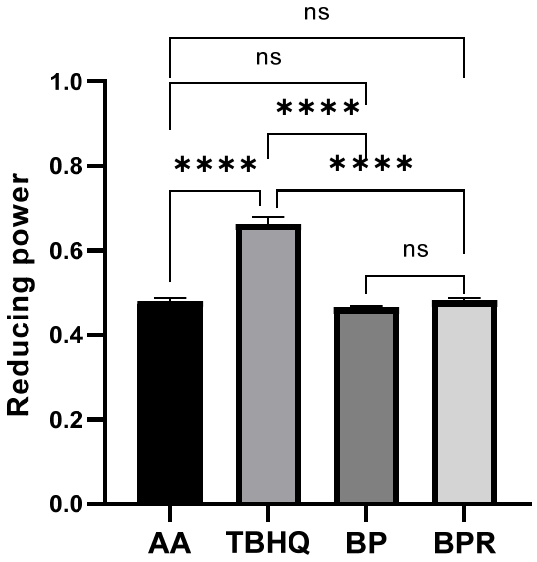
Figure 3. In vitro reducing power of the extracts. Different numbers of asterisks represent significant statistical differences (AA/TBHQ vs. samples; p ≤ 0.05), n = 3. Different numbers of asterisks represent significant statistical differences (**** p < 0.001; ns—not significant), n = 3.